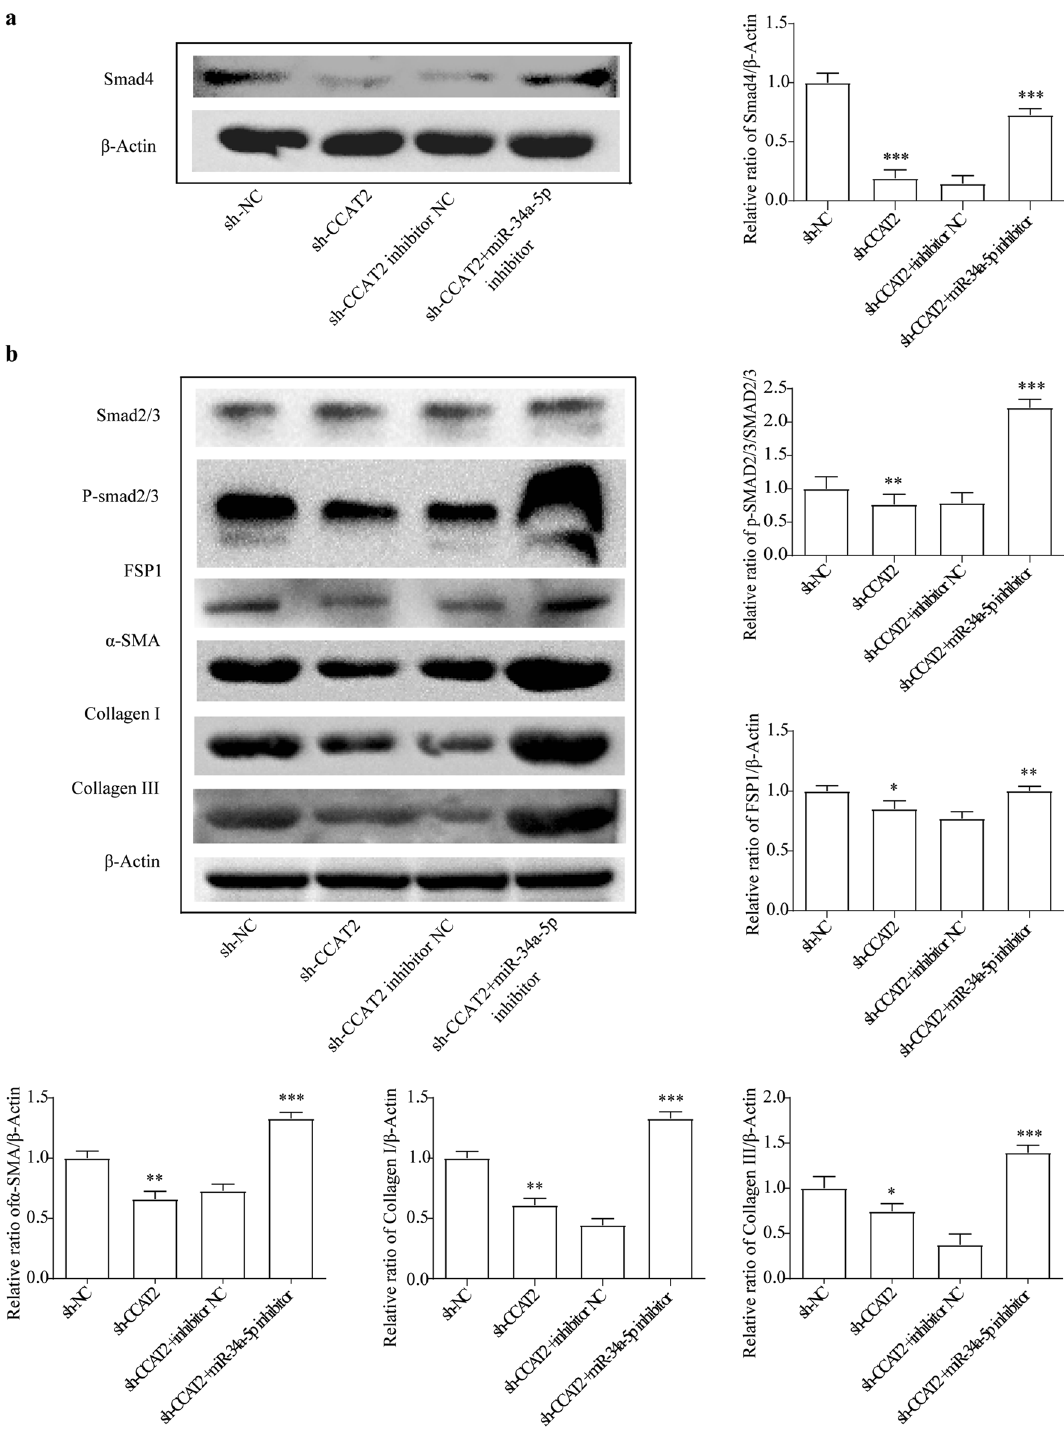
Figure 7. CCAT2 control miR34a-5p/Smad signaling axis. ( a ) Smad4 protein level were checked after miR- 34a-5p mimic and inhibitor treatment. ( b ) Smad signaling and ECM related proteins level were checked after miR-34a-5p mimic and inhibitor treatment.*, p < 0.05, ** , p < 0.01,***, p < 0.005. β-actin was used as an internal control. Data are reported as means ±